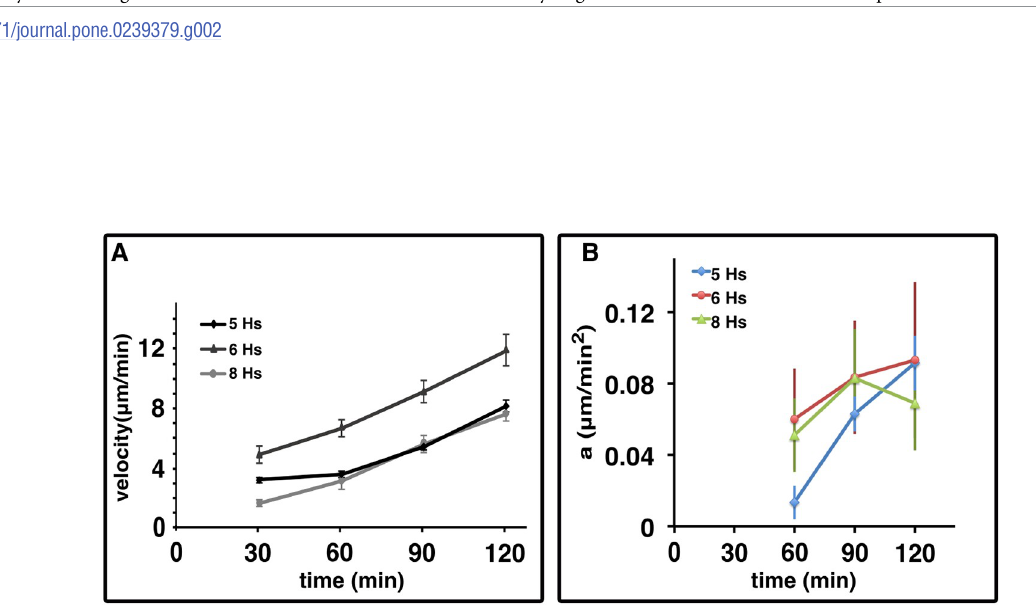
Fig 3. Cell acceleration. A. Migration velocity of Ax2 cells starved for 5, 6, and 8 hours. B. Cell acceleration over time for cells starved and pulsed 5, 6 or 8 hours. All data are represented as mean ± s . e . m .